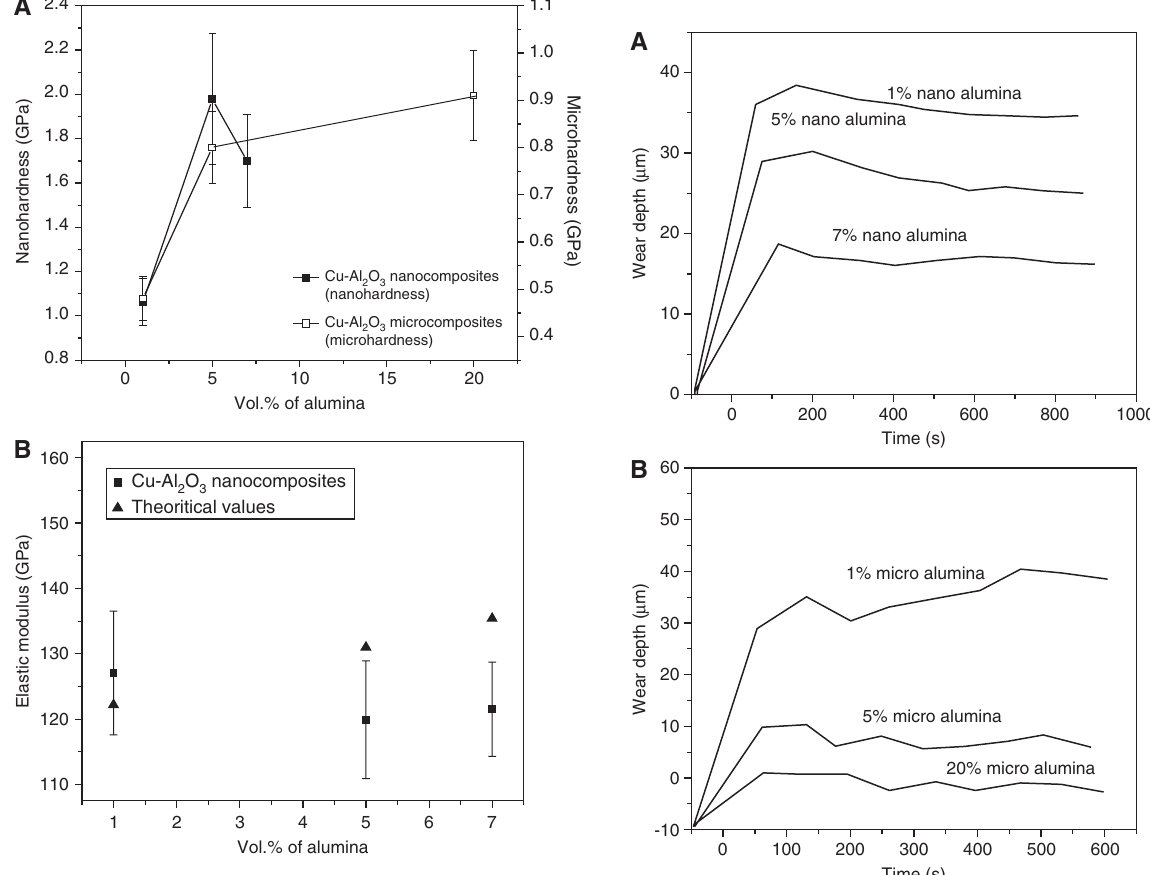
Figure 5: Wear depth vs. time plot for (A) nanocomposites and (B)